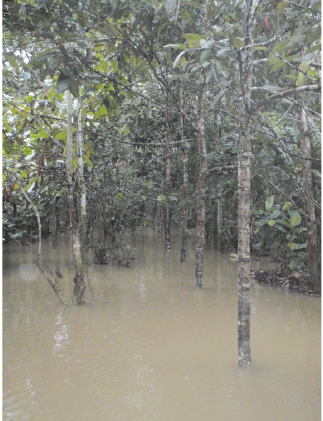
Figure 3: Image of annual flooding at Sampadi Forest Reserve, Lundu, Sarawak reforestation